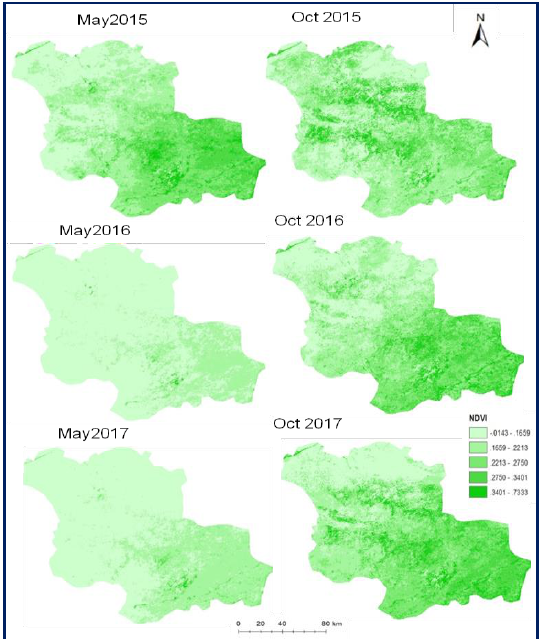
Fig.5: Temporal and spatial variation in NDVI of the study area.